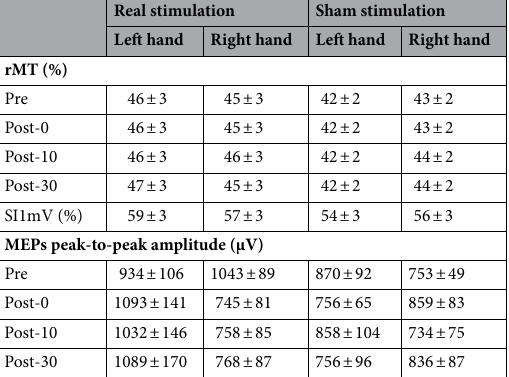
Table 1. The summary of results in Experimental 1. Data are shown as mean ± SEM. rMT resting motor threshold, MEPs motor evoked potentials, SI1mV intensity to obtain a 1 mV MEPS peak-to-peak amplitude.